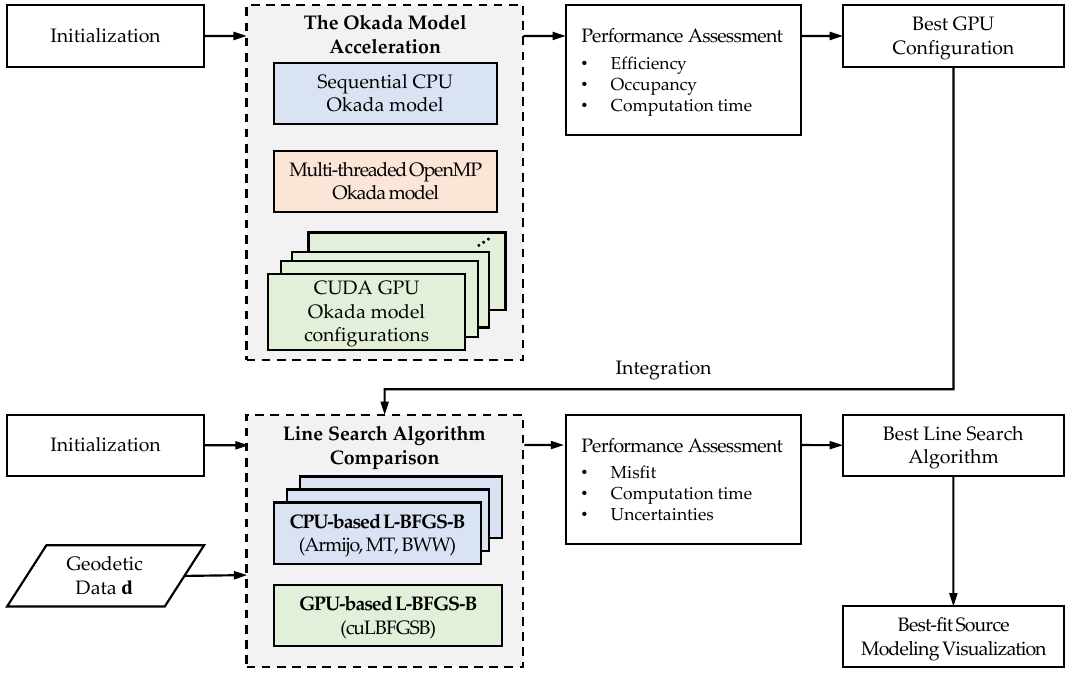
Figure 2. Schematic workflow of our